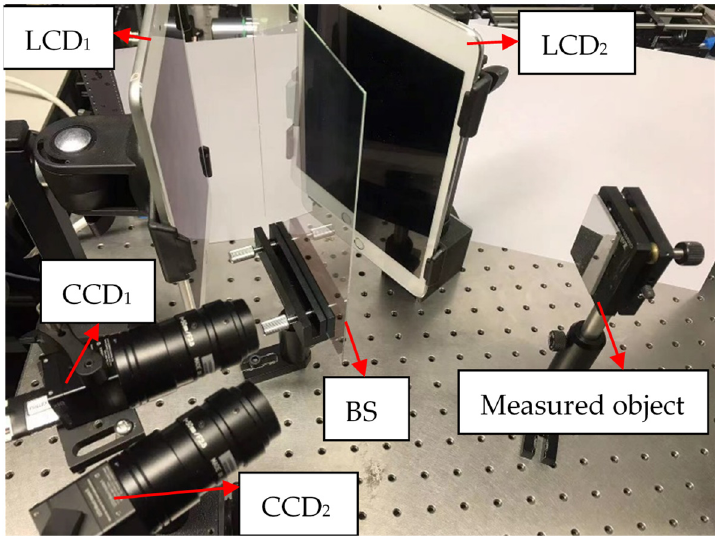
Figure 6. Experimental setup.